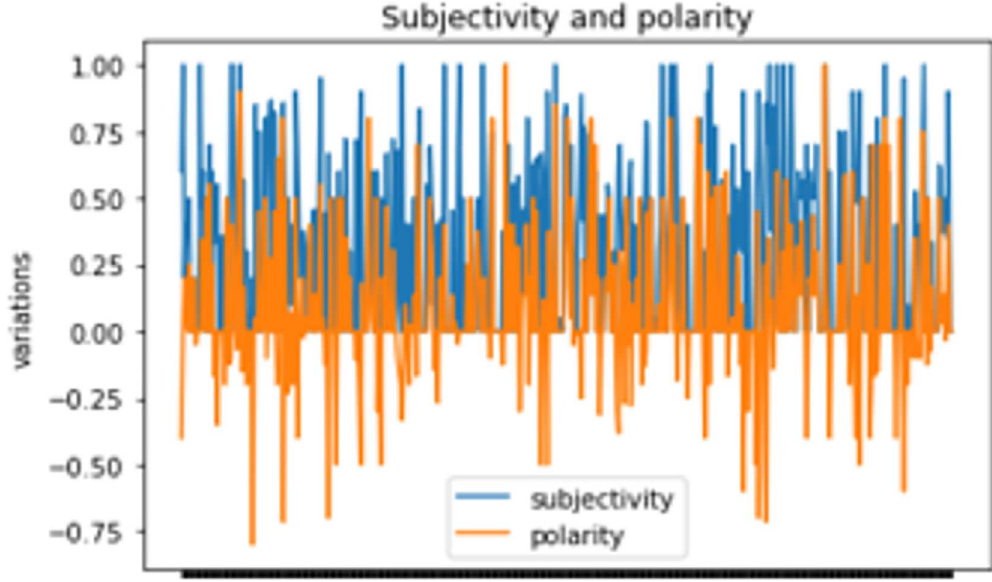
Fig 18. Subjectivity and polarity of